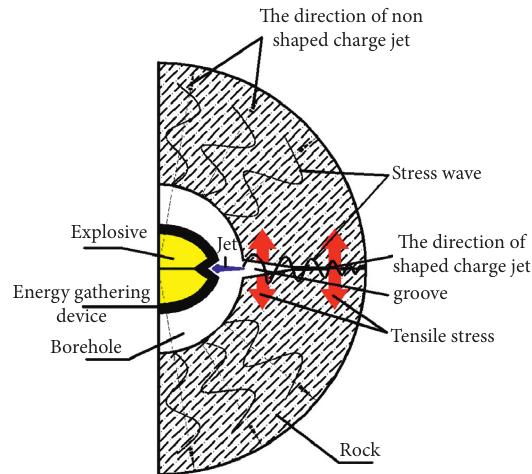
Figure 1: Mechanical model of single-hole elliptical and bipolar shaped charge tension blasting.